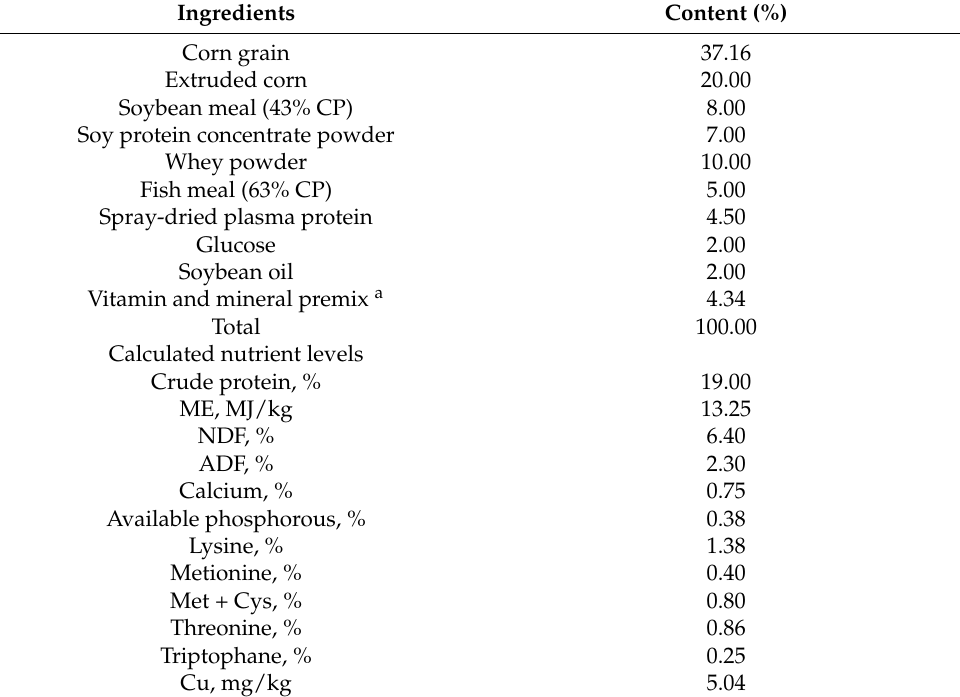
Table 1. Basal diet ingredient and nutritional component (as-fed